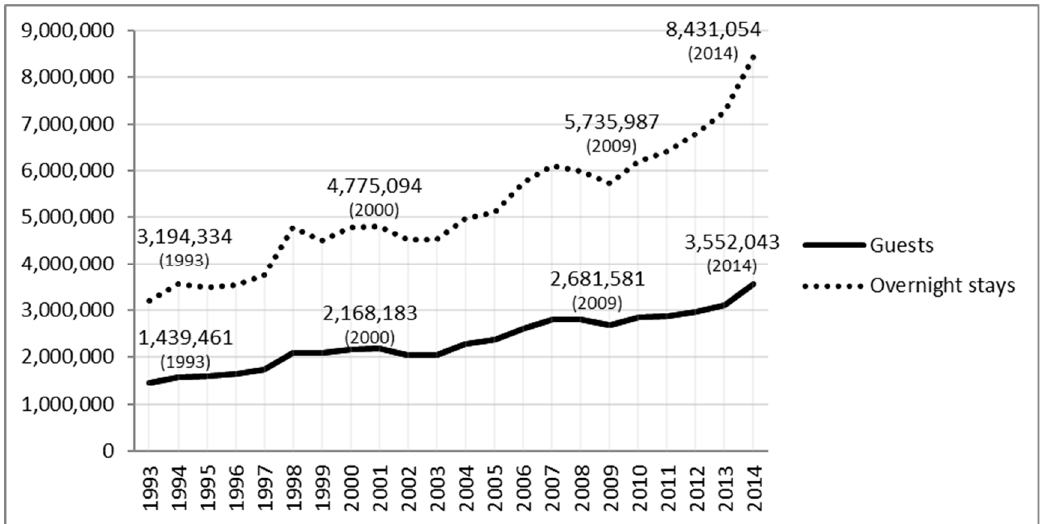
Figure 2. Evolution of guests and overnight stays in hotels in Lisbon. Source: Observatório de Lisboa (2015). Treatment performed by the author .